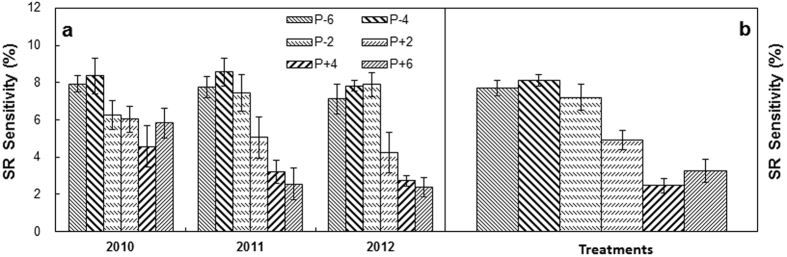
Precipitation sensitivity (percent changes per 10% precipitation change) of soil respiration (SR, annual means) in the three growing seasons, respectively (a) and across the three growing seasons (b). P−: mean sensitivity averaged across the three precipitation-reduction treatments; P+: mean sensitivity averaged across the three increased precipitation treatments; Other abbreviations see Fig. 1.